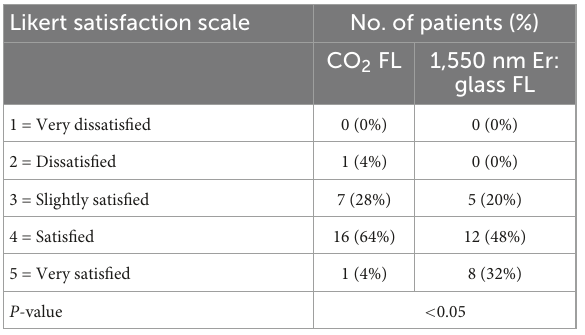
treatment (average 4.19 ± 2.12 scores). Post-inflammatory hyper-pigmentation was noted in two patients (8%) on the right side and in six patients (24%) on the left